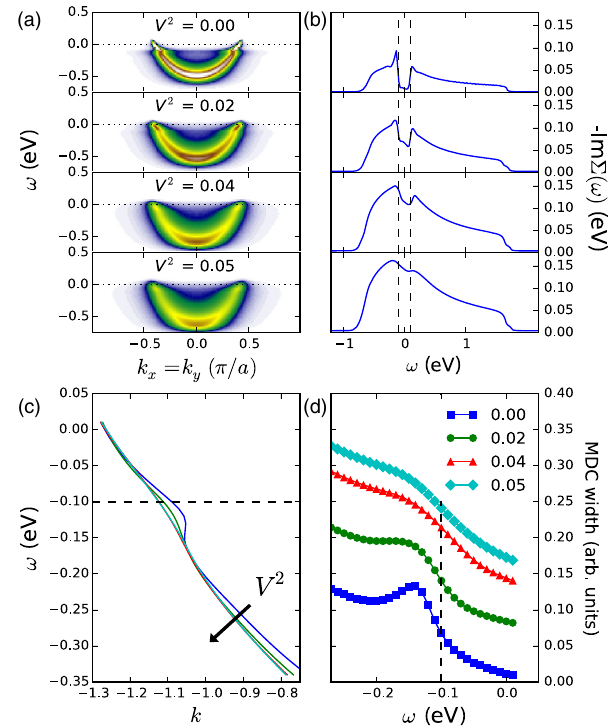
FIG. 5. Effect of combined electron-impurity and electron- phonon scattering in equilibrium. (a),(b) Equilibrium ARPES spectra and self-energies ½ − Im Σ ð ω Þ(cid:2) for various impurity scat- tering strengths V . The phonon-scattering strength is kept constant at g 2 ¼ 0 . 02 eV. (c),(d) Extracted dispersion ϵ ð k Þ and MDC widths from the ARPES